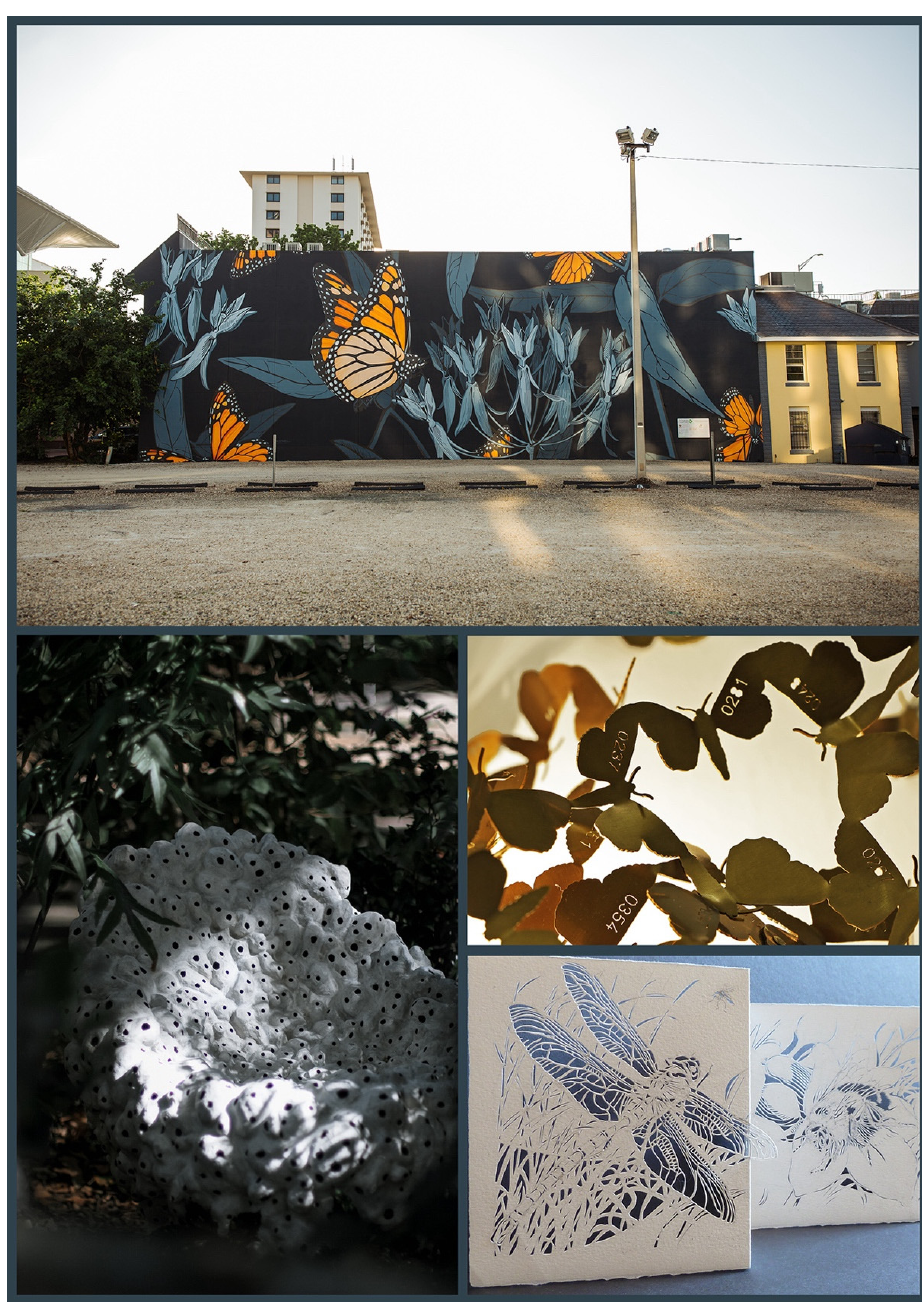
Figure 6. Art expressing concern for the insects or the environment, when human involvement was not made explicitly clear. One of Jane Kim’s monumental monarch murals in her Migrating Mural series, Midnight Dream ( top ; 2018) spans 3500 square feet in downtown Orlando, Florida, directly across from City Hall. Marlène Huissoud, also concerned about insect pollinators, has created a series of functional sculptures, Please stand by ( left ; natural clay and binder, 2021), within which urban pollinators can find shelter. Katharina Mischer and Thomas Traxler (mischer’traxler studio) have created a series of installations of metal moths appearing to fly near lit bulbs, each bulb attracting a different species of moth. Each metal moth is numbered and represents one moth remaining in Austria ( limitedMoths ; ongoing since 2008). These moths ( middle right ) represent Catocala conversa (Esper, 1783) in patinated brass. Vera Ming Wong created Airborne ( bottom right ; cut paper, 2012) with concern “about the myriad assaults by humans upon insects and other invertebrates.” All images are courtesy and copyright of the artists.